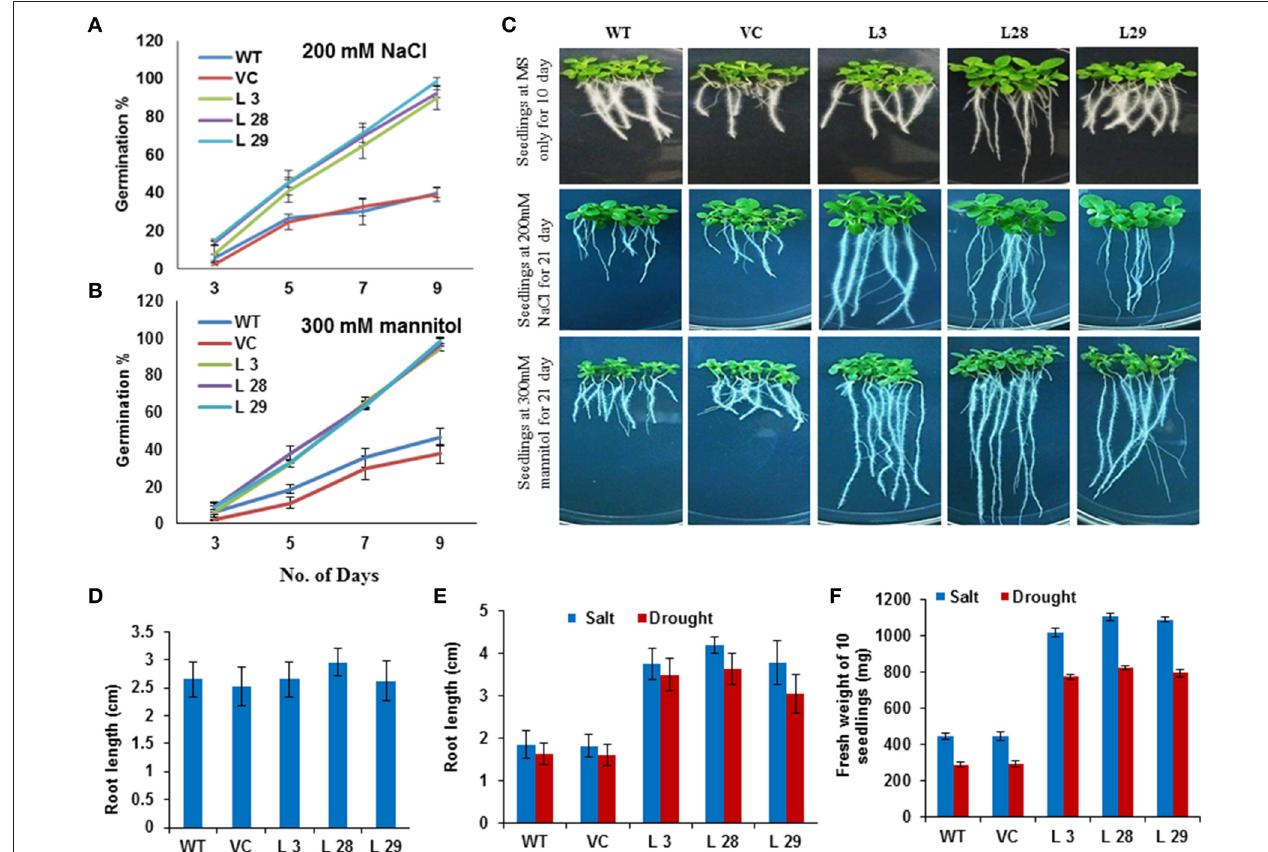
FIGURE 2 | Effect of SbSLSP on stress tolerance in T 2 transgenic tobacco. (A,B) Germination of SbSLSP transgenic and wild-type plants in MS medium supplemented with 200mM NaCl or 300mM mannitol. The percentage of germinated seeds was calculated based on the number of seedlings that reached the cotyledon stage by 9 days. (C) Root growth comparisons of the germinated seedlings of transgenic and WT plants, which were grown on vertical plates for 10 days in MS media for control experiment and 21 days for MS media supplemented with 200 mM NaCl or 300 mM mannitol for stress experiment. (D,E) Graphical representation of root measurements of transgenic and wild-type plants in control and stress conditions (salt or drought stress), respectively. Seeds of each line were germinated and planted on MS agar, or MS agar supplemented with 200mM NaCl or 300mM mannitol in triplicate. Root length was measured at 10 days for MS agar and 21 days for MS agar supplemented with 200mM NaCl or 300mM mannitol. Values are the mean ± SD (triplicate measurements; n = 10). (F) Fresh weight measurement of 21-day-old seedlings in salt and drought stress. Values are the mean ± SD (triplicate measurements; n =